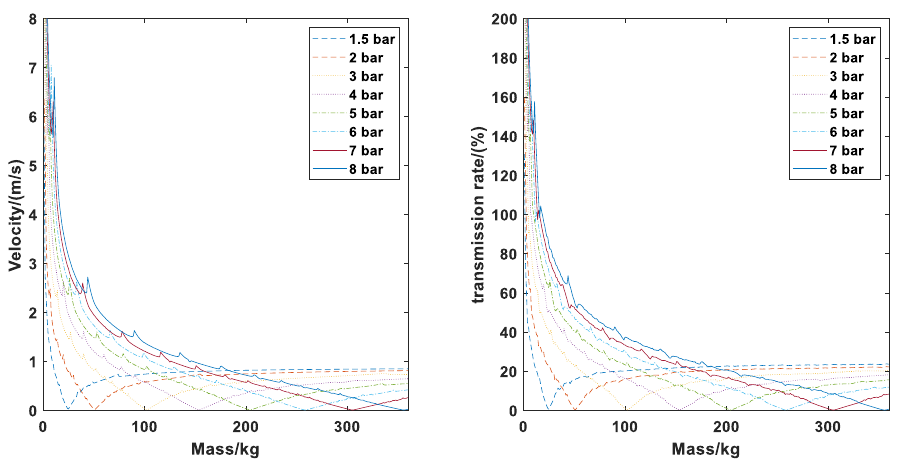
Table 3. Optimal results between the payload mass and the absolute pressure.